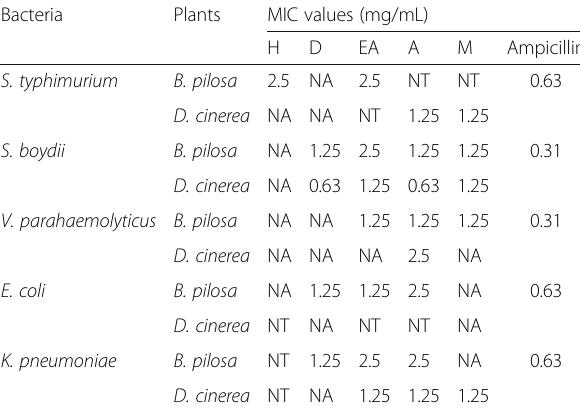
Table 3 The MIC values of B. pilosa and D. cinerea leaf extracts after exposure to simulated gastric